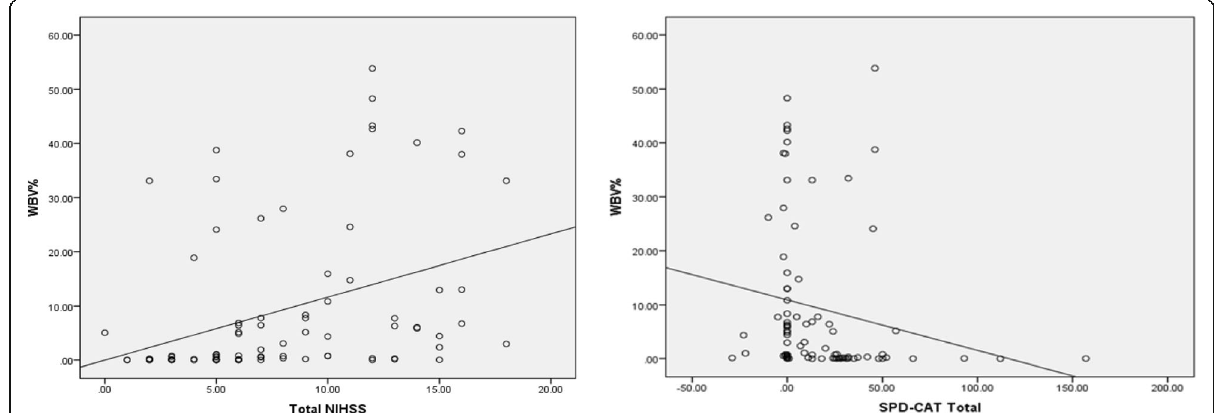
Fig. 4 Correlation between total NIHSS and LV% and total SPD-CAT and LV%